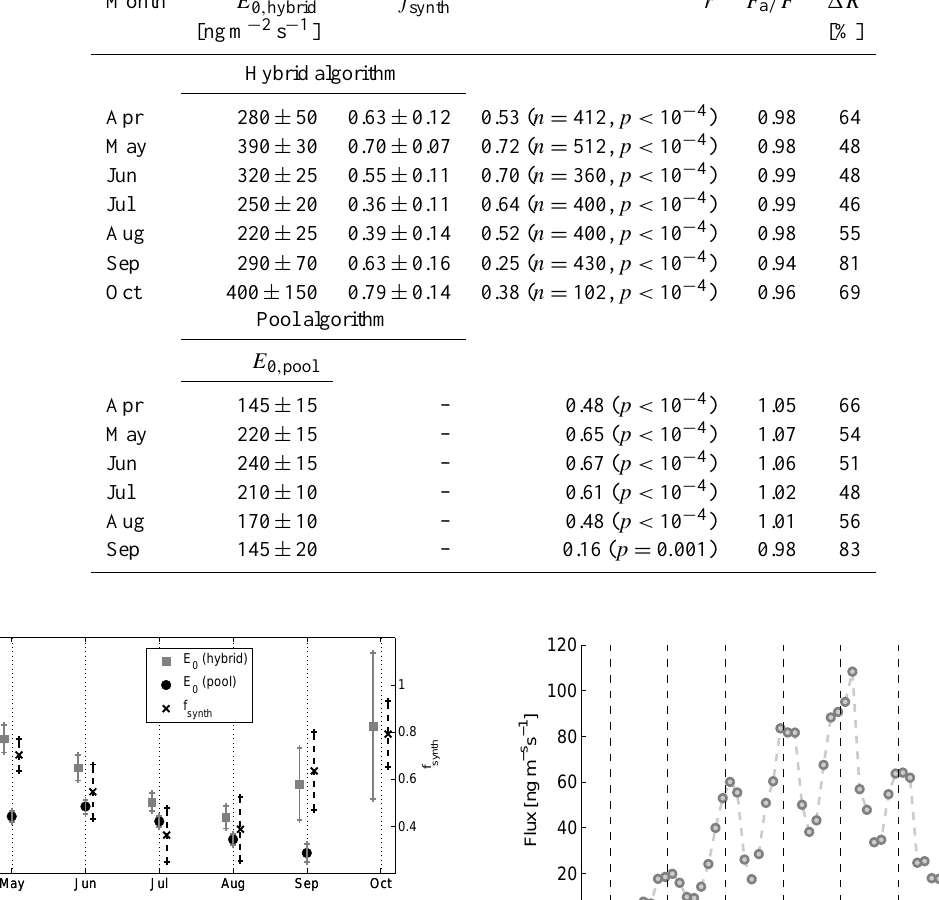
Table 4. The table presents monoterpene emission parameters of a hybrid algorithm, E 0 , hybrid , and f , including 95% confidence intervals (years 2010–2013). The table shows also correlations coefficients ( r ), relative errors between the measurements and the calculated values ( (cid:49)R ), and a ratio, F a /F , where F a is an average value of the calculated emissions, and F an average value of the measurements. There are also corresponding values of the pool algorithm. If the p value of a correlation was larger than 0 . 0027, the result was disregarded as statistically insignificant, and those values are not shown in the table.